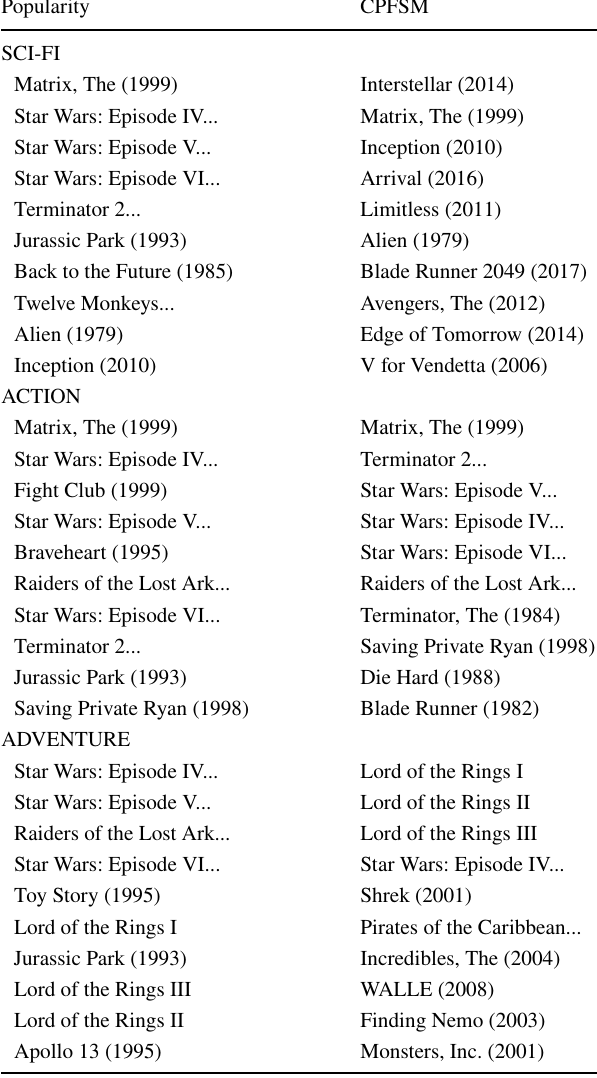
Table 3 Tag rankings for MovieLens